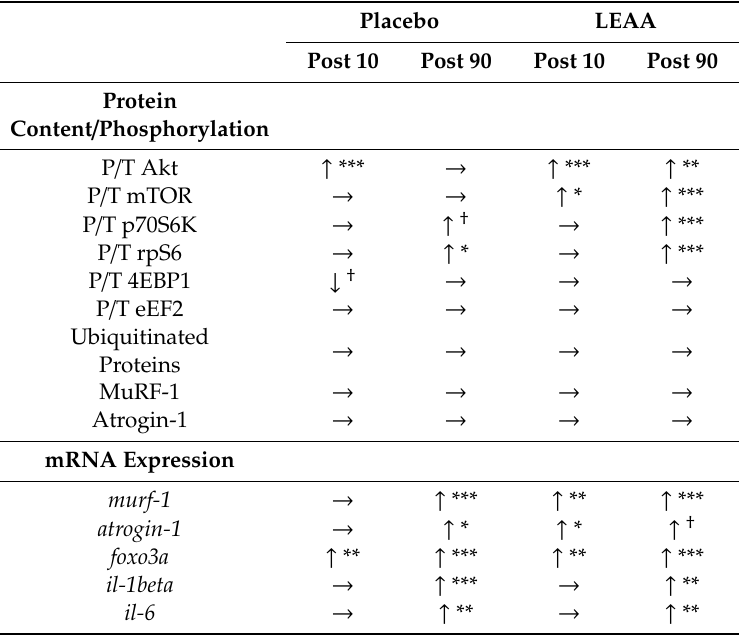
Table 4. Time-dependent changes in muscle parameters.